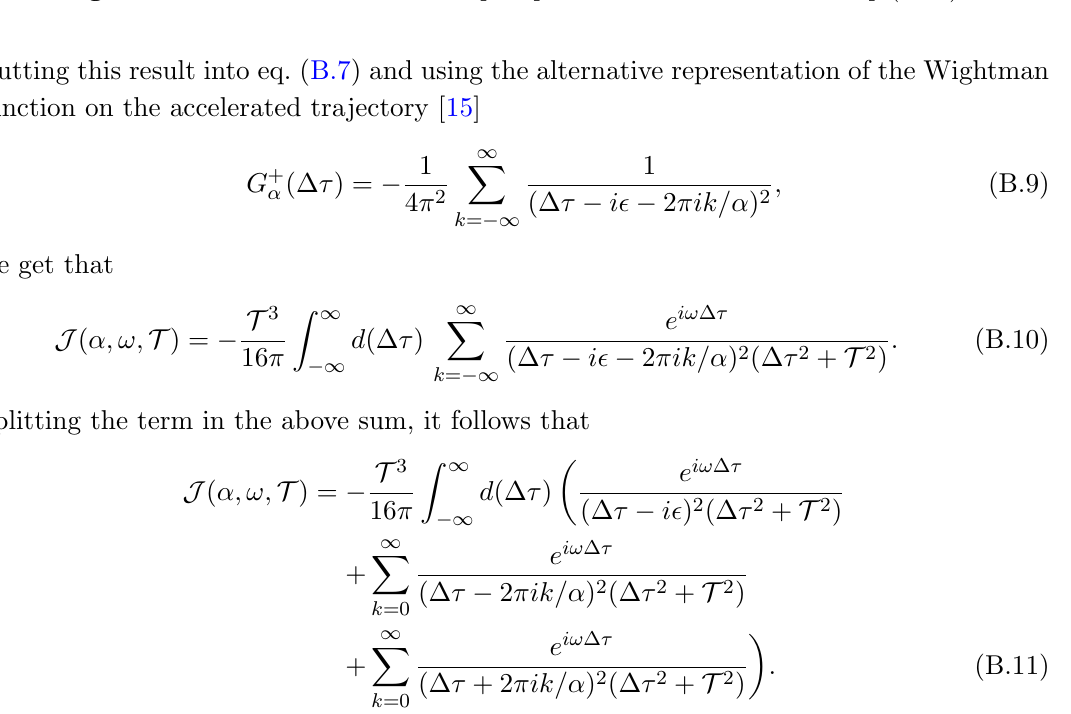
Figure 11. Pole structure in the complex plane of (cid:1) (cid:28) for the terms in eq.